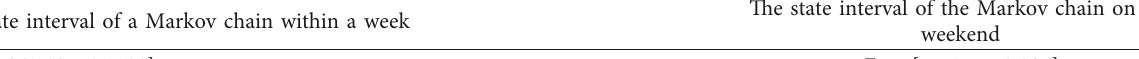
Table 2: State interval of the Markov chain.